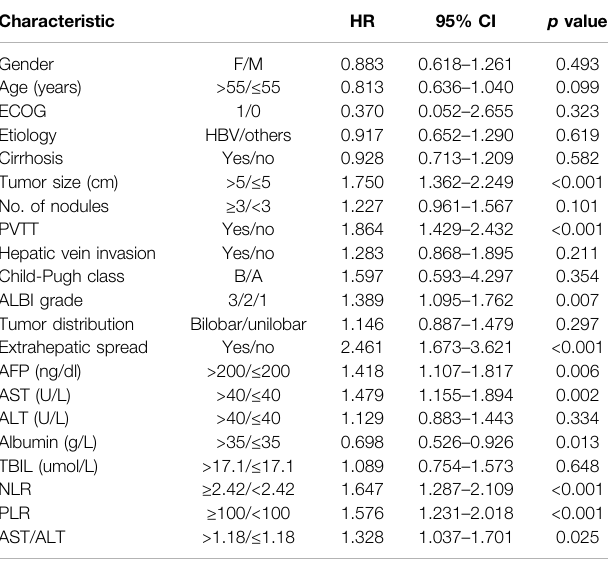
TABLE 2 | Univariate analysis of risk factors associated with overall